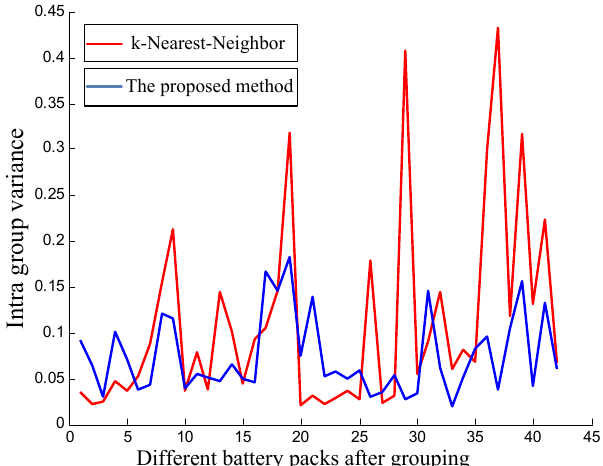
Figure 11. The comparison of intra-group variances: Results of original k-nearest-neighbor algorithm; Results of the proposed method. Note that the proposed method can achieve smaller variances and better intra-group consistency.